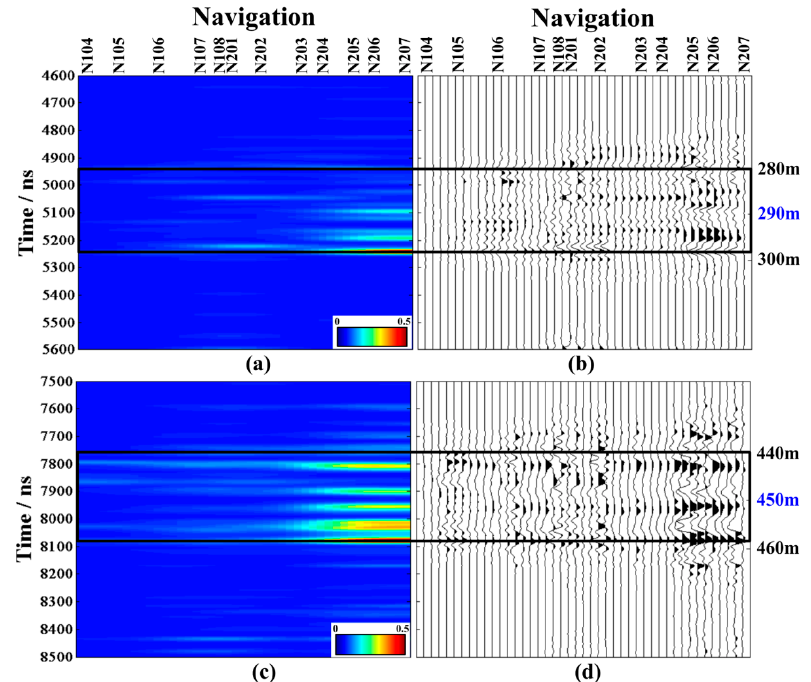
Figure 9. Zoomed local correlation map and zoomed section of the final extracted signal. ( a ) Local correlation map (Near 290m) ( b ) Extracted signal (Near 290m) ( c ) Local correlation map (Near 450m) Local correlation map ( d ) Extracted signal (Near 450m).